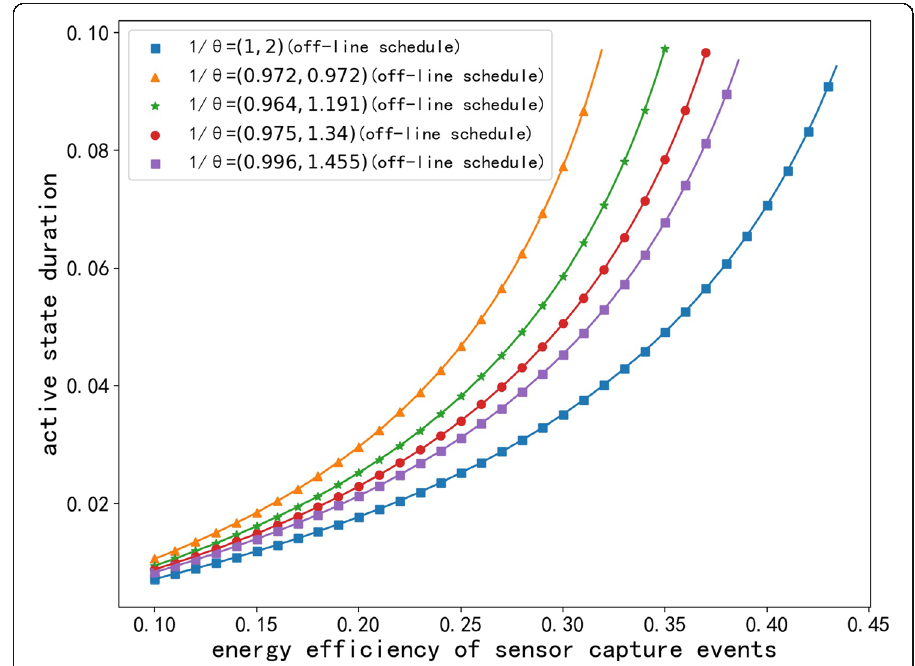
Fig. 5 Effect of energy efficiency of sensor captures events on active state duration in different scheduling